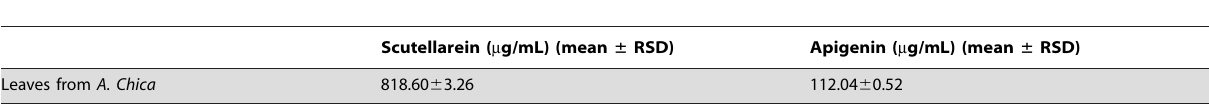
Table 5. Quantification of scutellarein and apigenin in extract of leaves from A. chica by